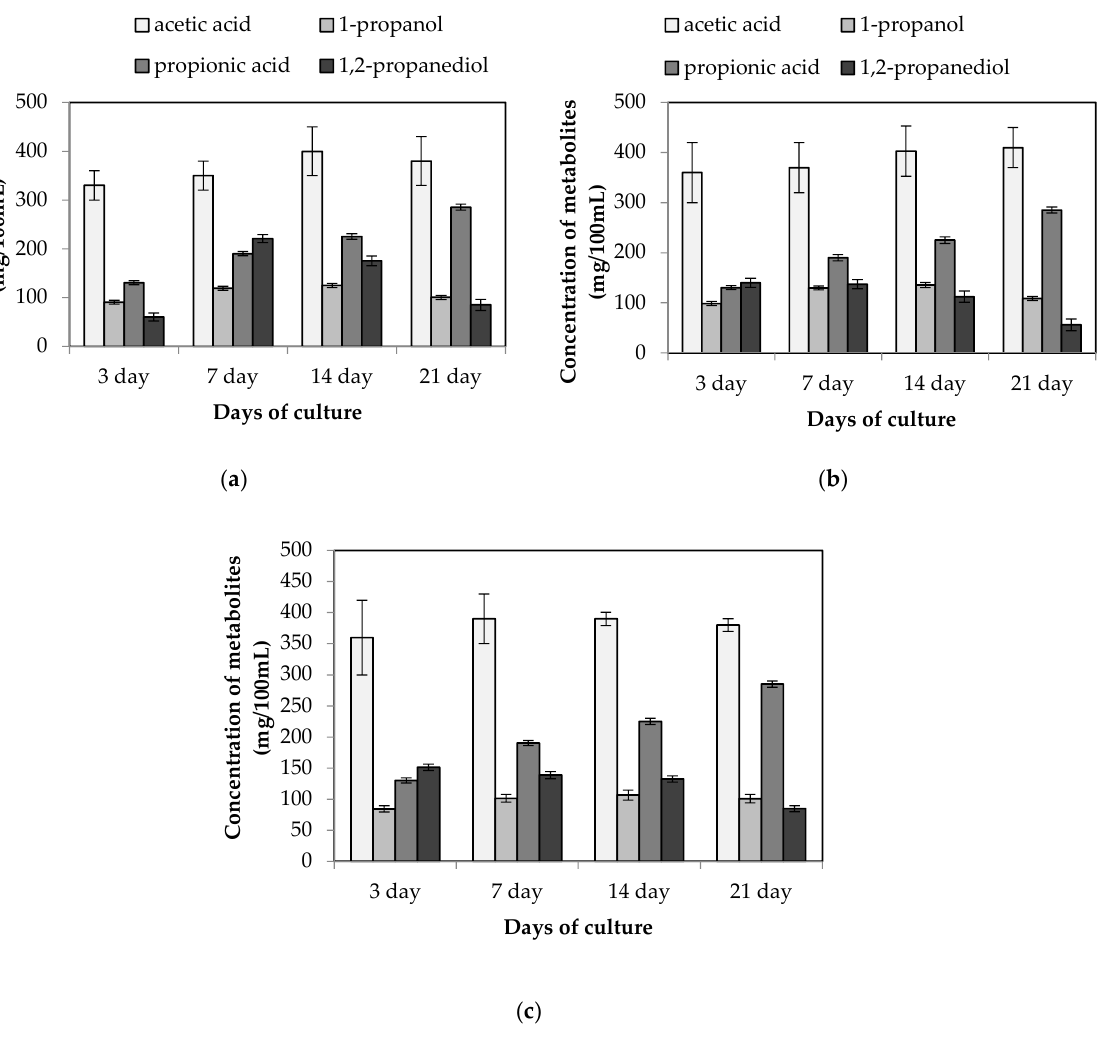
Figure 1. Metabolite profile of supernatant resulting from co-fermentation of strains L. buchneri KKP 2047p and L. diolivorans KKP 2057p in medium containing 8.0 g/L 1,2-propanediol and glucose as a carbon sources in concentration: ( a ) 2.5 g/L; ( b ) 5.0 g/L; ( c ) 10.0 g/L. There was showed a standard deviation for each measurement.